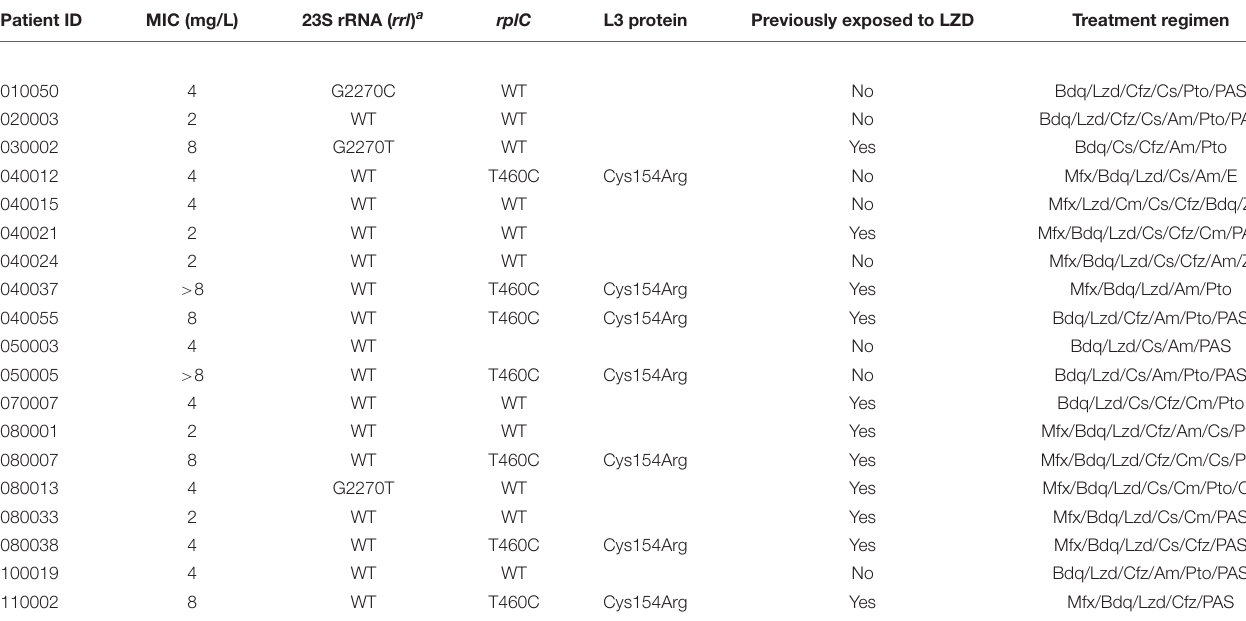
FIGURE 2 | MIC distribution of MDR-TB isolates with varying MIC values stratified by prior LZD exposure history. MIC, minimum inhibitory concentration; ECV, epidemiological cutoff value; CC, critical concentration. The blue column represents results from MTB isolates with prior exposure to LZD; the orange column represents results from MTB isolates without prior exposure to LZD. TABLE 1 | Mutations conferring linezolid resistance in the MTB isolates with initial